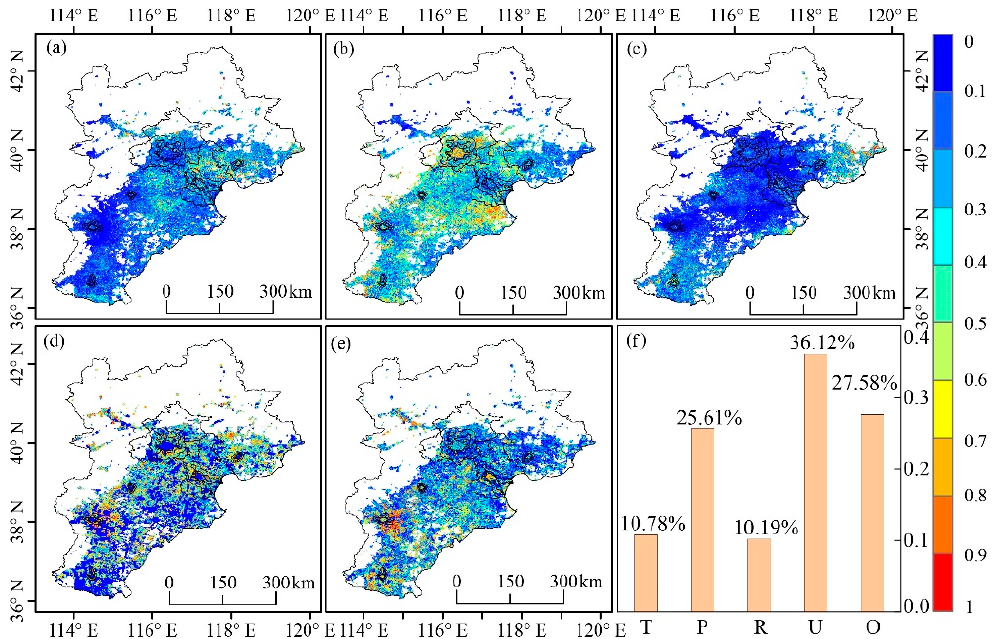
Figure 6. Contribution of each factor to FVC changes: ( a – d ) are the contributions of temperature, precipitation, radiation, and urbanization, respectively, to FVC changes, ( e ) shows the contributions of other factors not considered to FVC changes, and ( f ) is the average contribution of various factors to FVC changes in the BTH region.